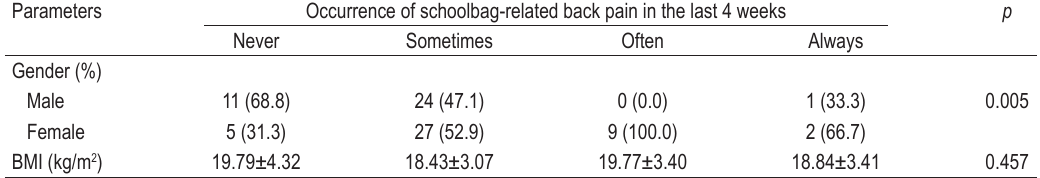
TABLE 9. Gender and BMI in relation to back pain Parameters Occurrence of schoolbag‑related back pain in the last 4 weeks